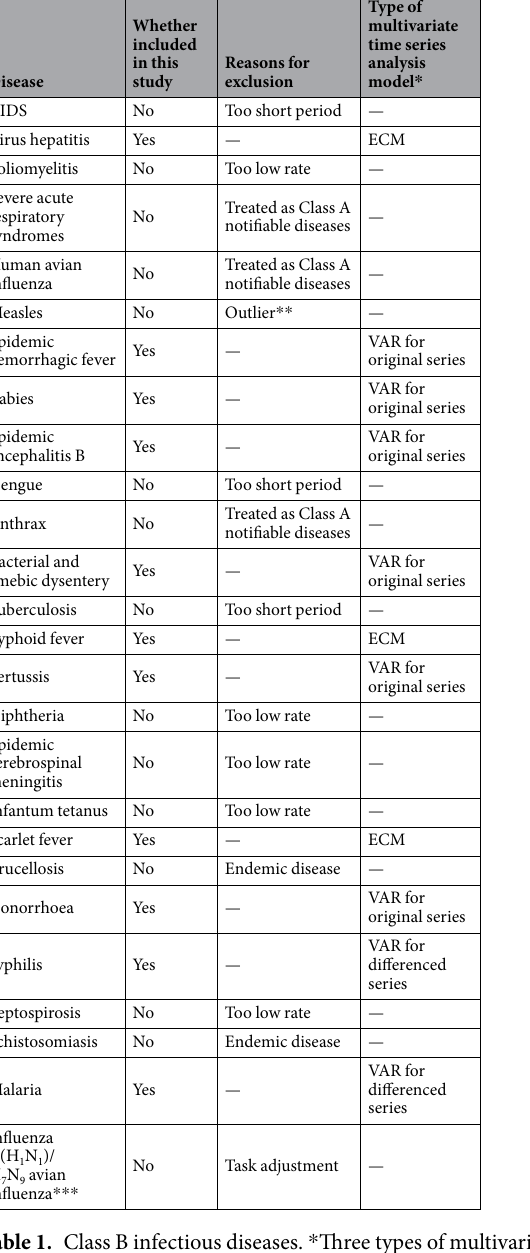
Table 1. Class B infectious diseases. * Three types of multivariate time series analysis models were used in this study, that is, the VAR for original series, VAR for differenced series and the ECM, see more information in the rest of paper. ** The incidence rate of measles was zero in 2003, but was far great than zero in 2002 and 2004. This study did not find reasonable explanation for this outlier, so measles was not included for analysis. *** According to regulation of government, influenza A (H 1 N 1 ) has been adjusted from Class B to Class C notifiable disease since 2014, while H 7 N 9 avian influenza was included as Class B since 2013